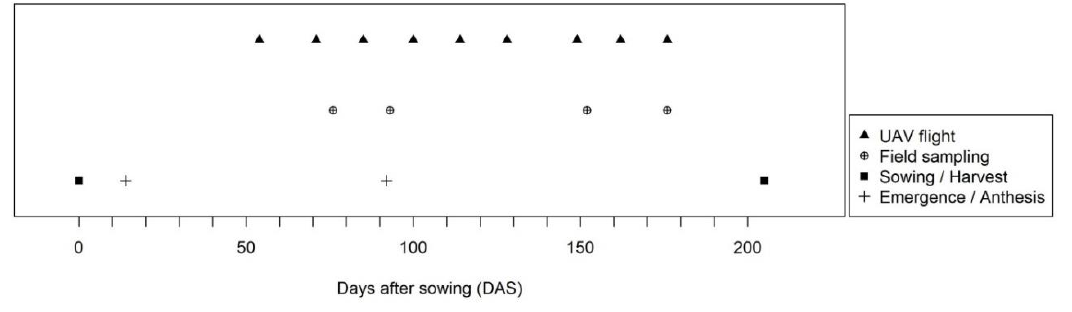
Figure 1. The study site is in Gembloux area (Wallonia, Southern Belgium) and consisted of 32 maize experimental plots (15 × 40 m).